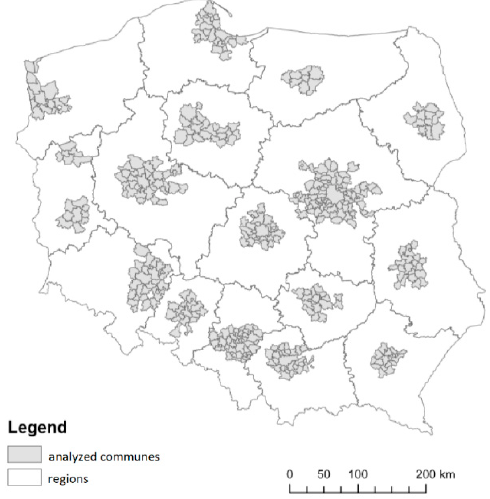
Figure 1. Analyzed area. Source: own based on Lity ń ski & Ho ł uj [6,75].